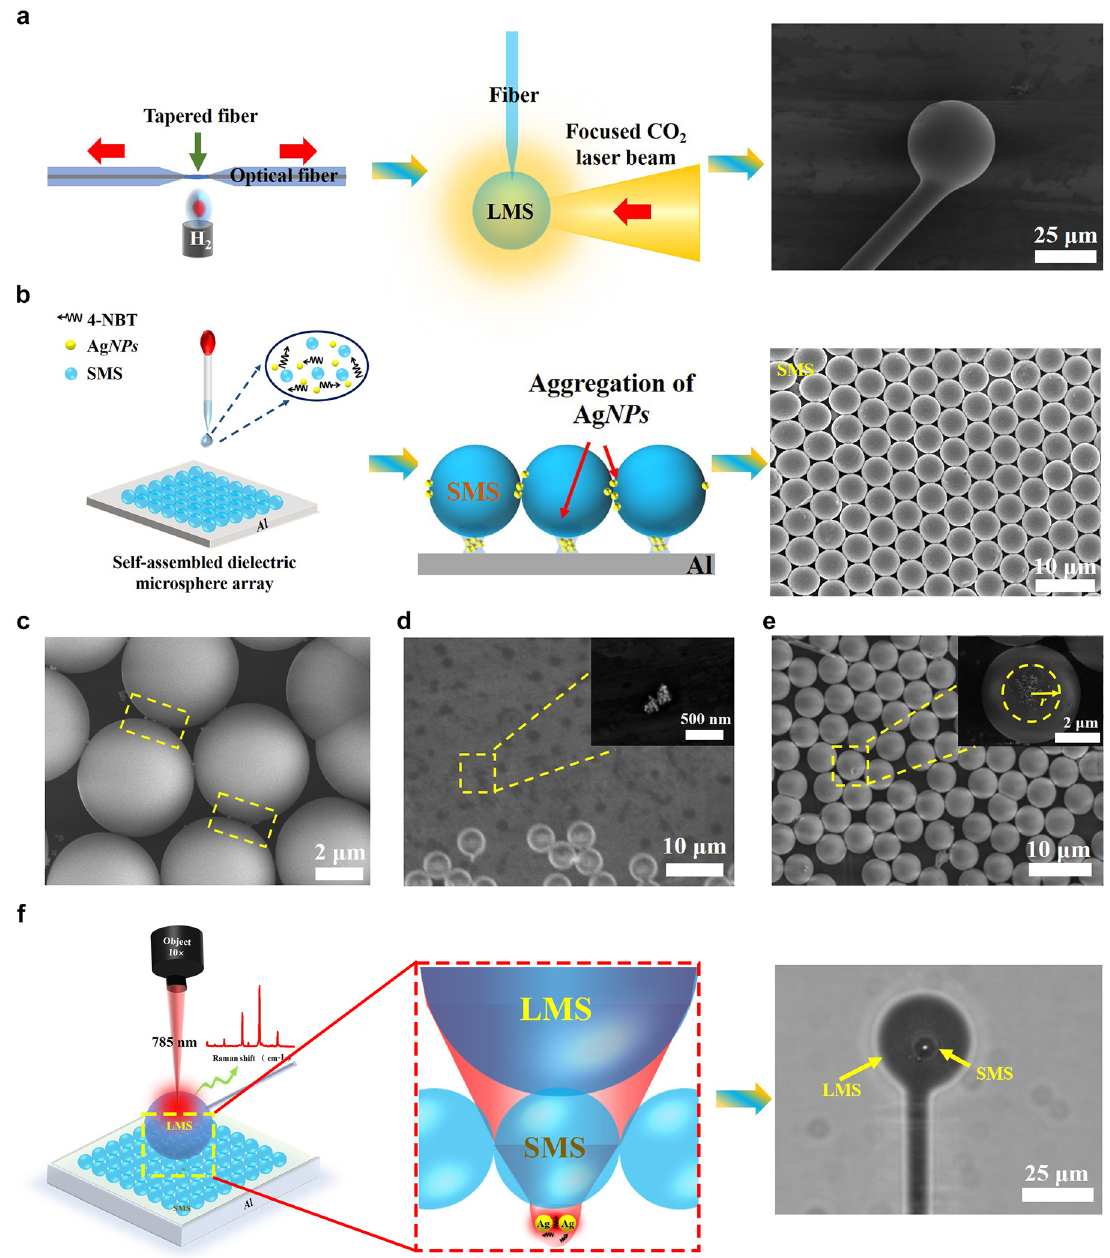
Figure 1: Schematic of CMS-SERS enhancer. (a) Fabrication of LMS via laser melting of tapered fibers. (b) Self-assembly of SMS with Ag NP s by drop-coating. (c) – (e) Close-up views of (c) gaps between SMS, (d) Ag NP s on Al substrate at the contact points of SMS, and (e) AgNP s aggregated on bottoms of SMS. (f) Typical structure of CMS-SERS enhancer, composed of LMS, SMS, and Ag NP s, for enhanced-Raman trace